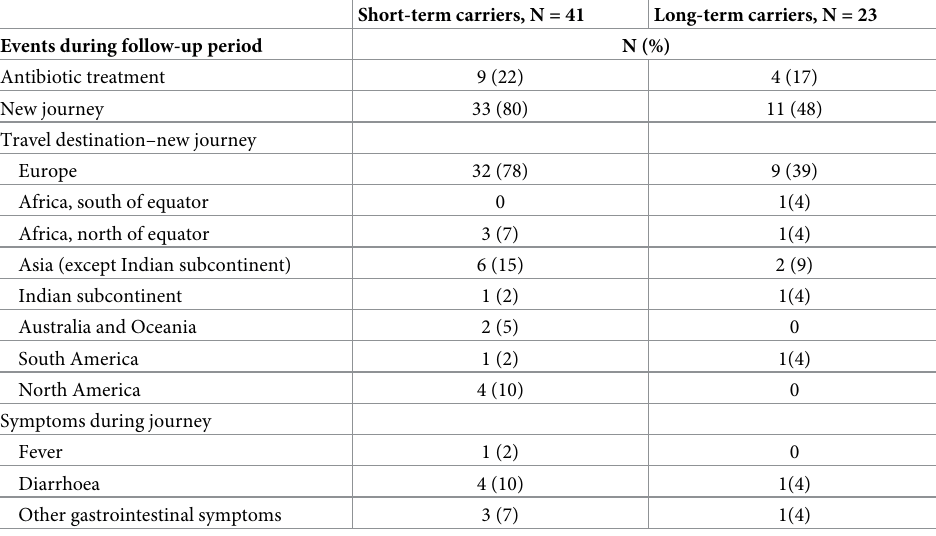
Table 2. Events during the follow-up period for short and long term carriers.